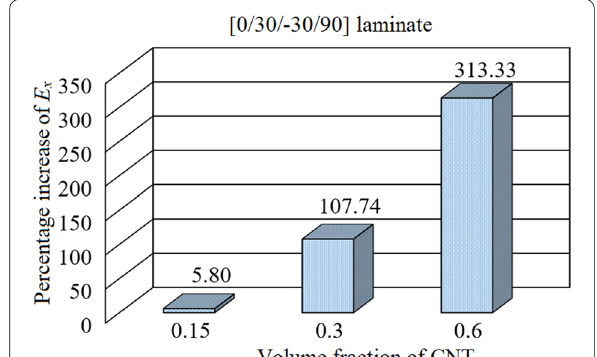
Fig. 7 Percentage increase in E x of CNT/epoxy with volume fraction as compared to CF/epoxy at a constant 60% CF volume fraction for [0/30/-30/90] stacking sequence of